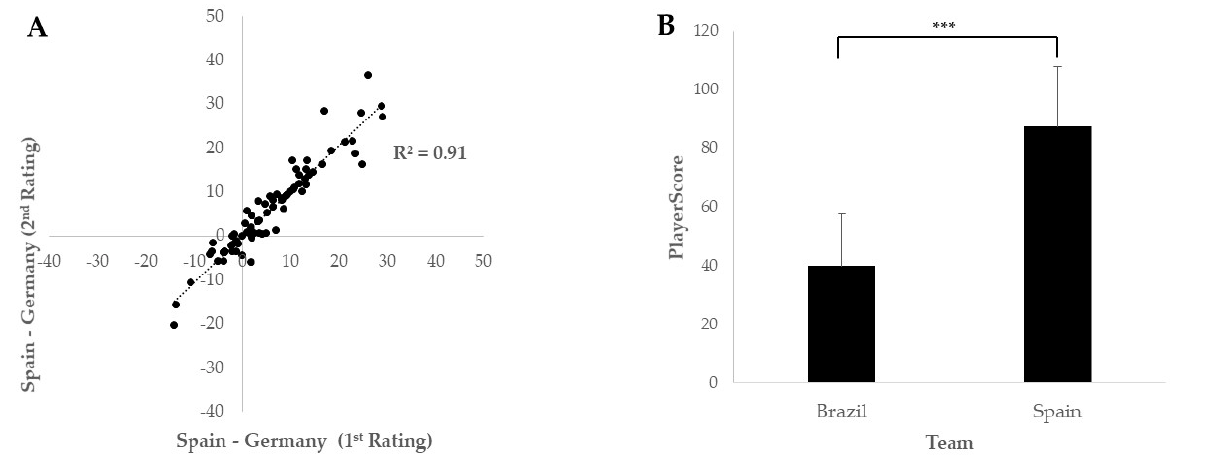
Figure 3. Linear regression plot of the PlayerScore team statistics between the first (1st) and second (2nd) rating of Spain against Germany ( A ), and bar graph of the PlayerScore team performance of Brazil and Spain ( B ). ( p < 0.001 *** ).